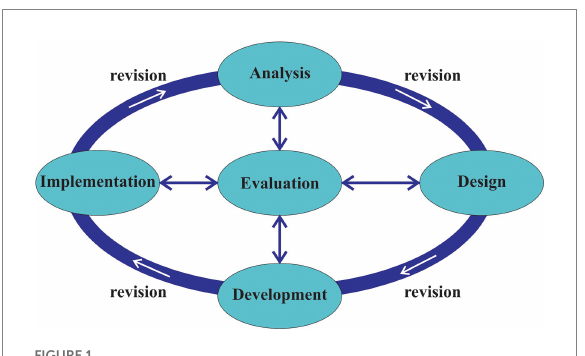
FIGURE 1 ADDIE development